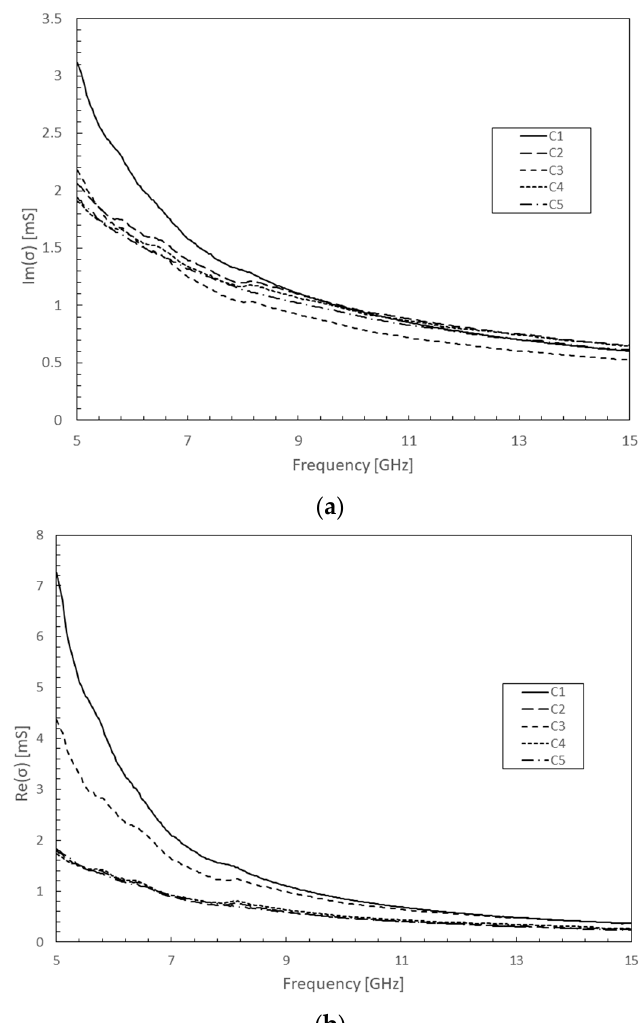
Figure 4. Experimentally extracted VA MWCNT complex conductivity measurements from five microwave devices (C1 to C5) incorporating identical bundle dimensions: ( a ) Real part; ( b ) Imaginary part.